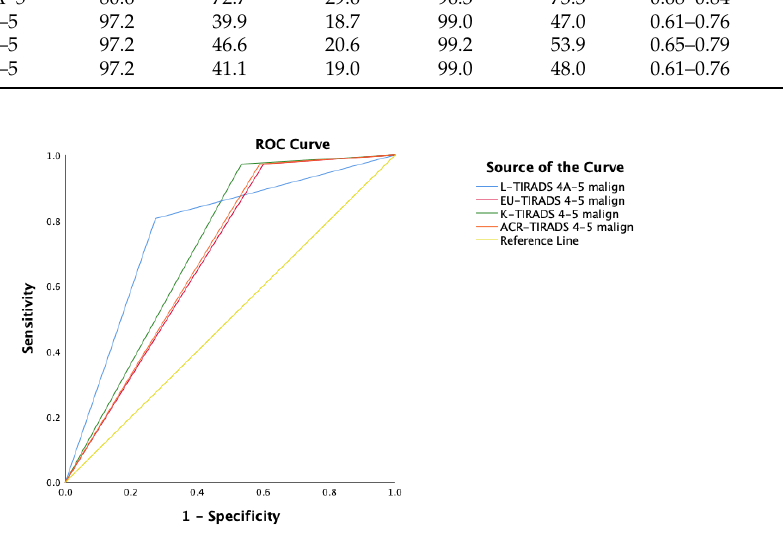
Table 7. Pooled estimates of the sensitivity, specificity, PPV, NPV, accuracy, and area under curve (AUC). TIRADS System Included Values